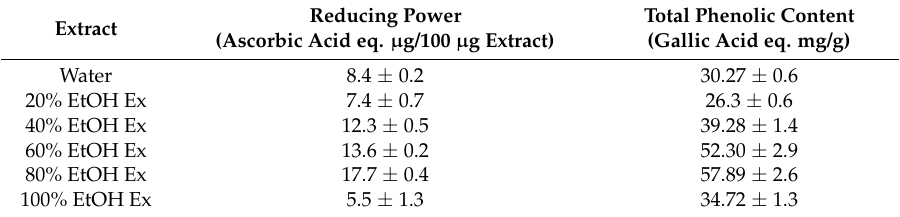
Table 5. Reducing power and total phenolic contents of D. morbifera leaf